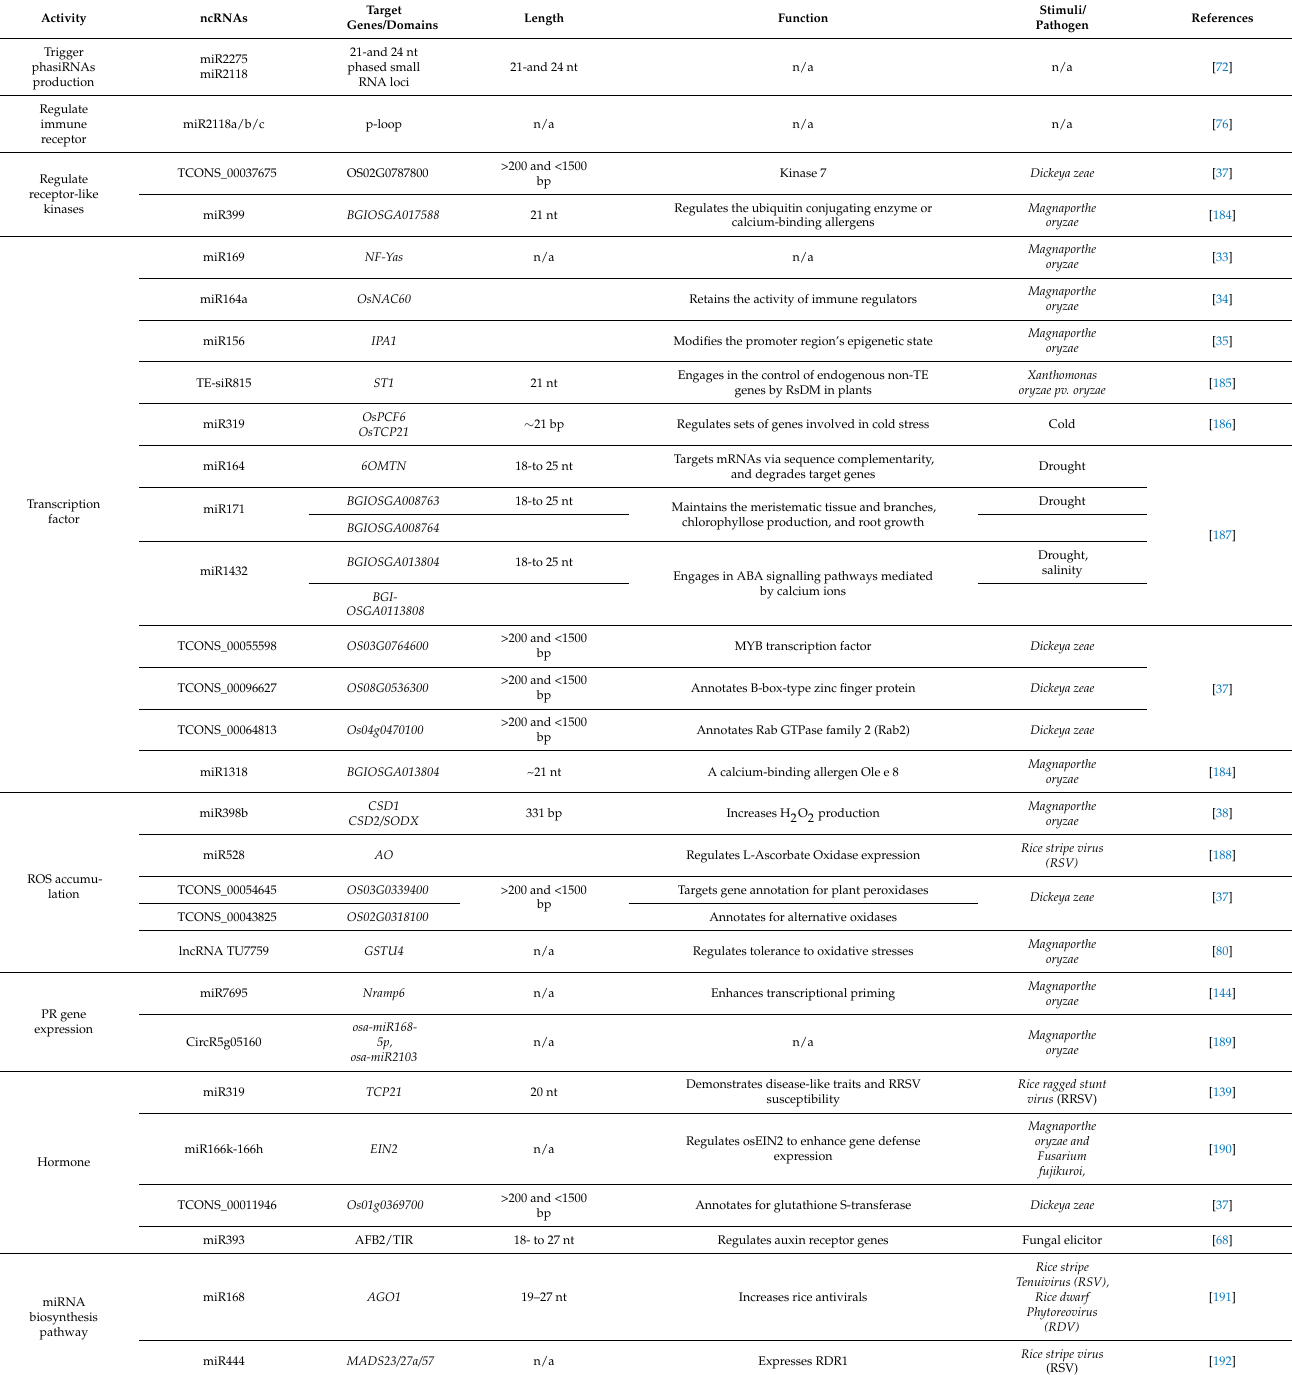
Table 2. The following table links the ncRNAs to their activity, and target